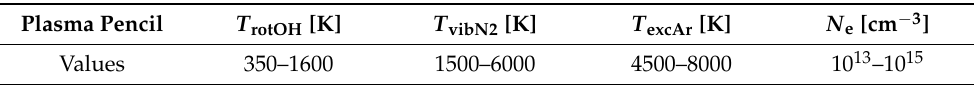
Figure 1. The plasma jet and the measurement of the electromagnetic field with a dipole antenna. Table 1. The characteristics of the plasma jet discharge as related to the full range of applicable operating conditions: an overview [19–21] (the temperatures T of the selected plasma components are determined through the optical emission spectra, and the density of the electrons N e is established from the spectral profile of the line H β ).